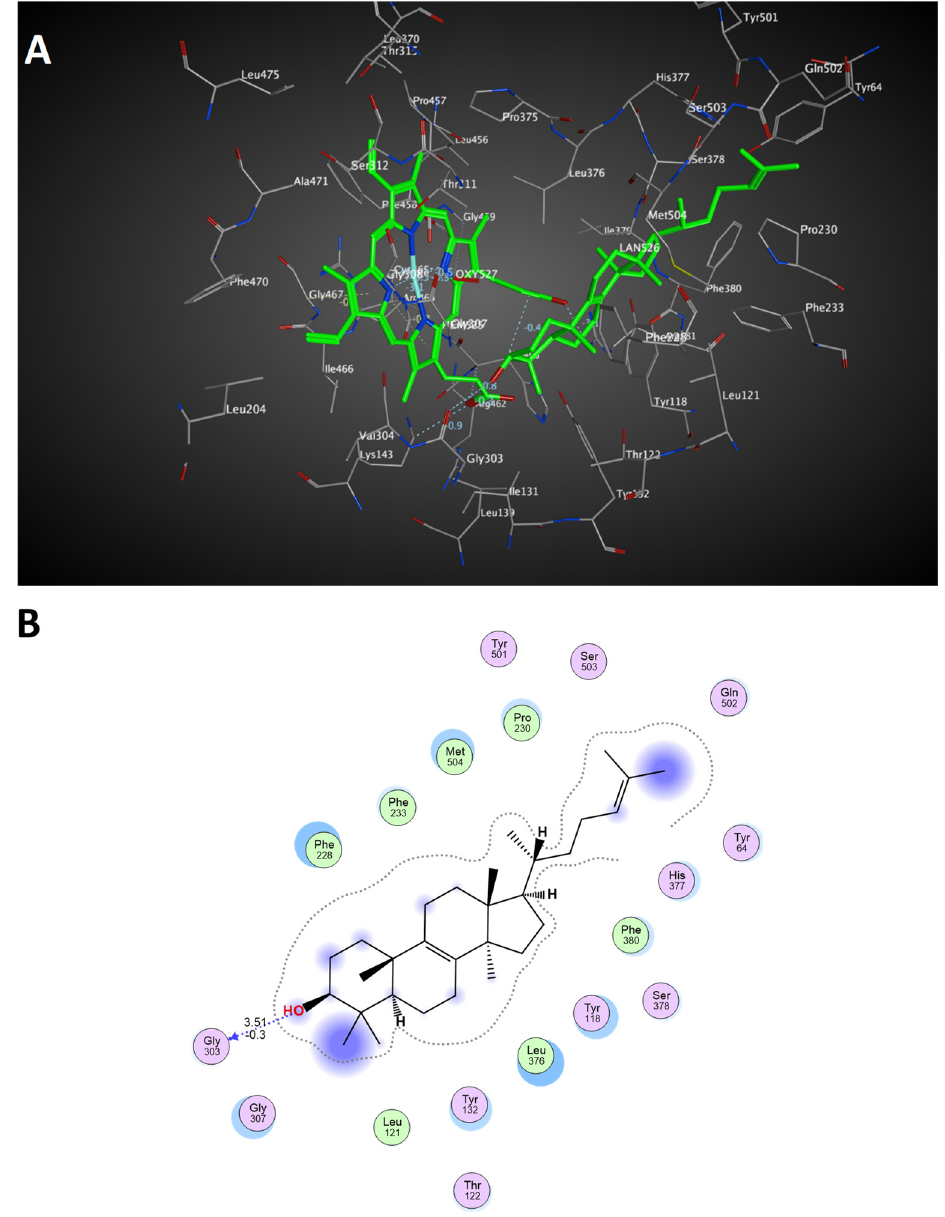
Figure 6. Predicted 3D binding site of C. auris 14- α -demethylase enzyme bound with heme and lanosterol: ( A ) 3D representation of binding site including heme and the natural substrate lanosterol (colored in green); ( B ) 2D interaction diagram of lanosterol with the binding site of C. auris 14- α -demethylase enzyme. Amino acids in contact with lanosterol are displayed as spheres. Violet spheres represent polar amino acids, while green spheres represent hydrophobic amino acids. Solvent-exposed regions of lanosterol are highlighted in blue. The hydroxyl group of lanosterol showing weak hydrogen bond interaction with glycine 303 ( − 0.3 Kcal/mol, distance 3.51 Å.